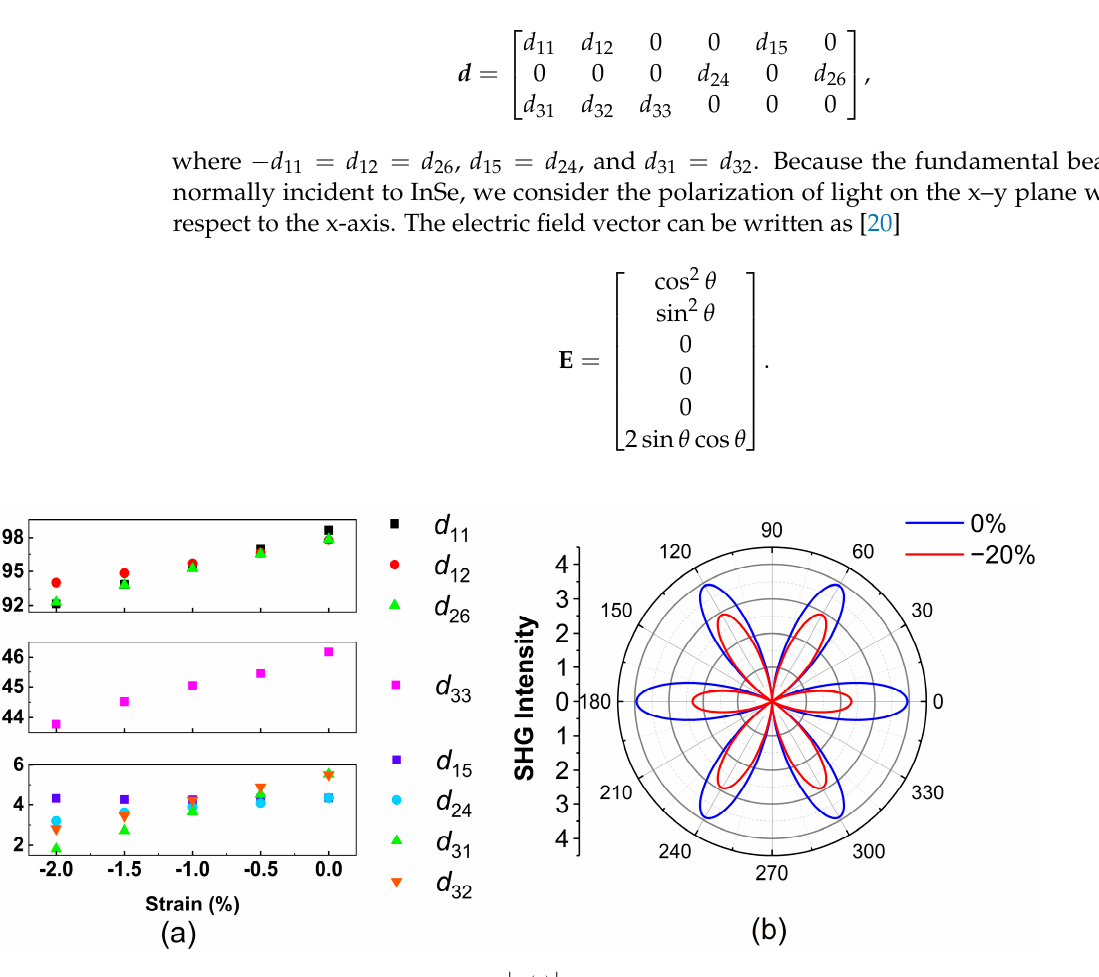
Figure 4. ( a ) Calculated nonzero (cid:3627)𝜒 ((cid:2870)) (cid:3627) components at photon energy 1.55 eV at different uniaxial strain levels. ( b ) Angle-resolved 𝐼 ∥((cid:2870)(cid:3104)) pattern under 0% and − 20% strain derived from the calcu- lated 𝜒 ((cid:2870)) at 1.55 eV.